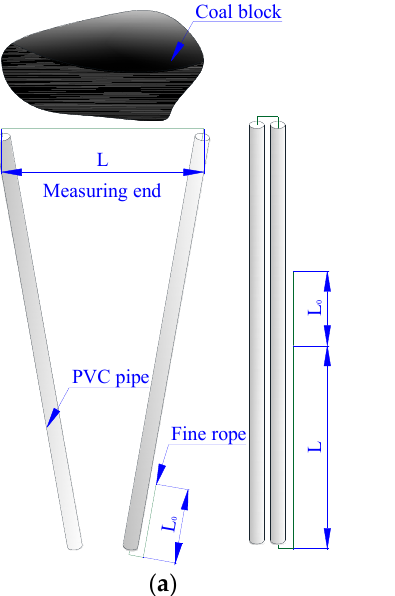
Figure 11. Method for measuring caving block size of top coal: ( a ) Measurement principle diagram and ( b ) Physical map.